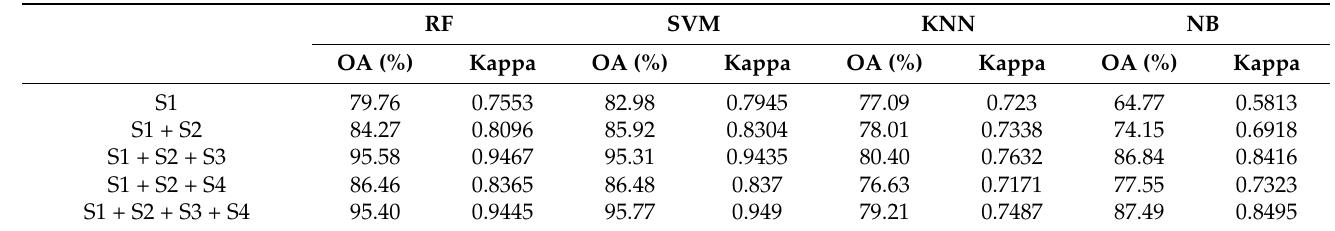
Table 4. Accuracy assessment for pixel-based classifiers under different feature